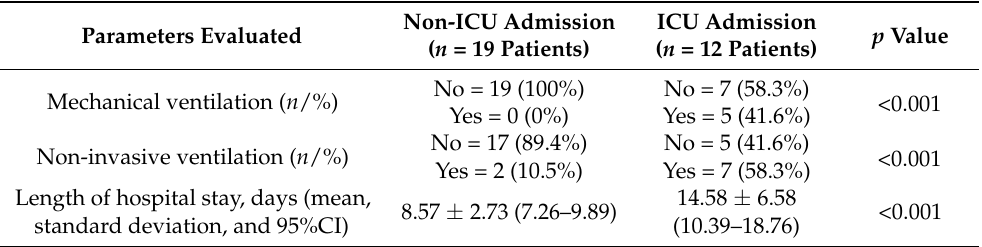
Table 4. A univariate analysis of the parameters evaluated during hospital stay for the patients included in our study.